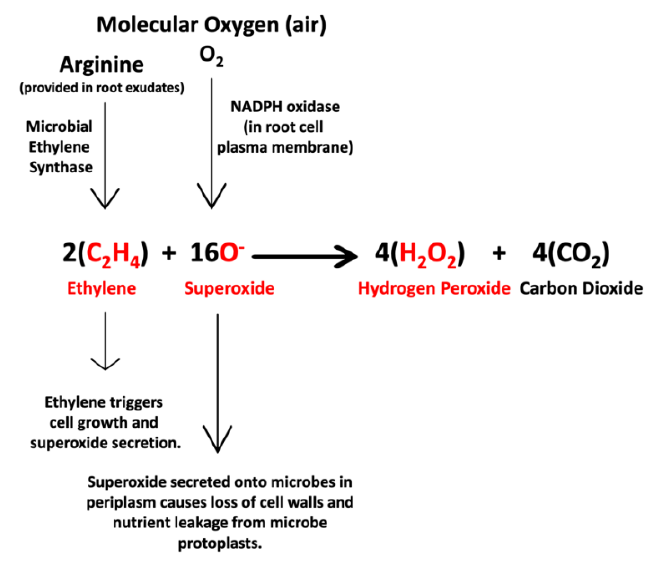
Figure 15. Chemical equation that represents the first interaction between endophytic bacteria and plant cells. In this interaction microbes produce and secrete ethylene onto plant cells. Ethylene triggers the plant cell to grow, release nutrients and release superoxide from NADPH oxidases (Nicotinamide Adenine Dinucleotide Phosphate Oxidases) on the plant cell plasma membrane. Some of the superoxide oxidizes cell walls from bacteria, induces nutrient leakage and may degrade them. Some of the superoxide reacts with ethylene to produce hydrogen peroxide and carbon dioxide. Reactants and products detected in histochemical analyses are indicated in red.